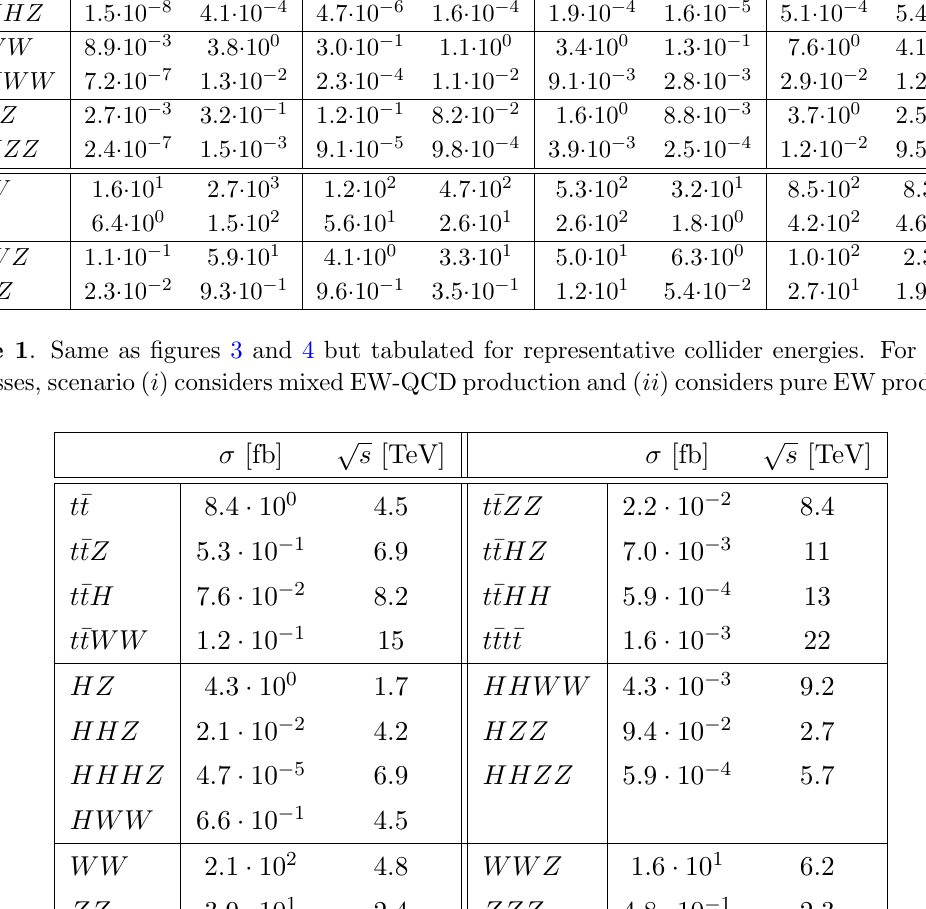
Table 2 . The value of collider energy